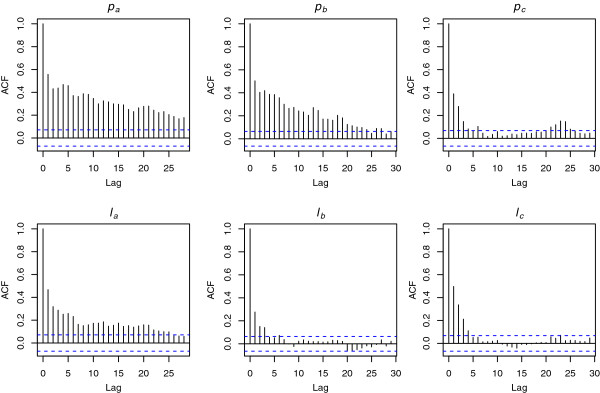
Sample autocorrelation function (ACF). Autocorrelation plots for parasite (pa,pb,pc) and leukocyte (ℓa,ℓb,ℓc) counts show correlations between valuesxi and lagged values of the counts for lags from 0 to 30. The lagged values can be written asxi-1,xi-2,xi-3, and so on. ACF gives correlations betweenxi andxi-1,xi andxi-2, and so on. The lag is shown along the x-axis, and the autocorrelation is on the y-axis. The blue dotted lines indicate bounds for statistical significance.